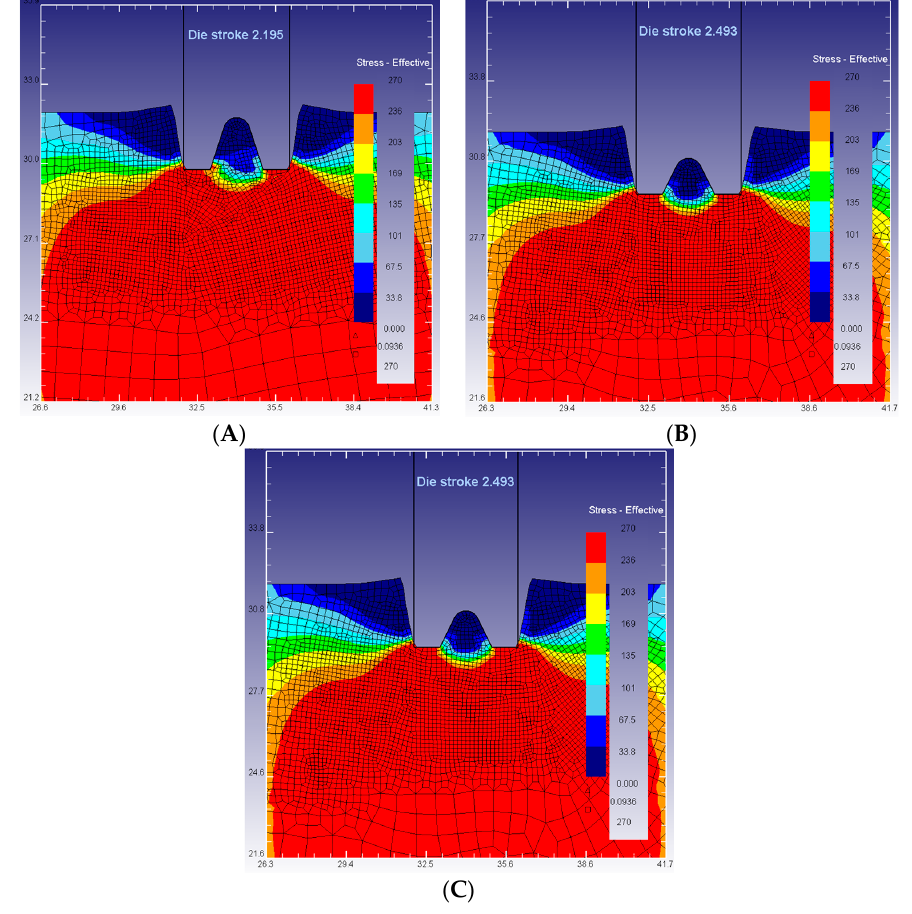
Figure 13. Nook study: 10% ( A ); 20% ( B ); and 30% ( C ).